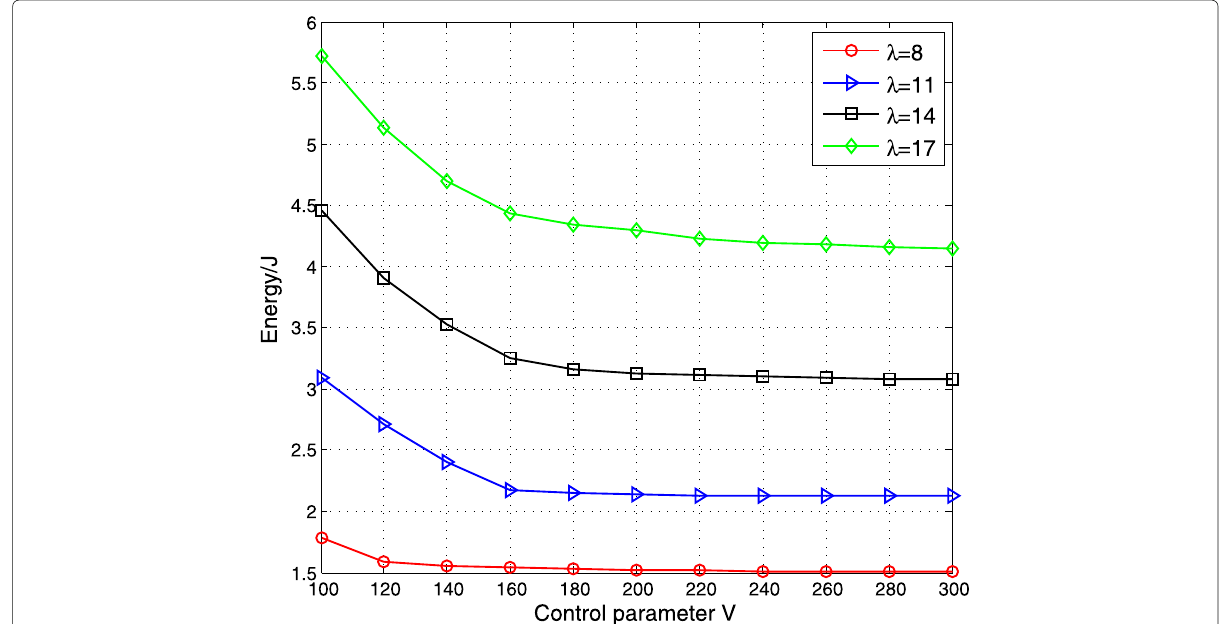
Fig. 4 The average energy consumption versus the control parameter V with different